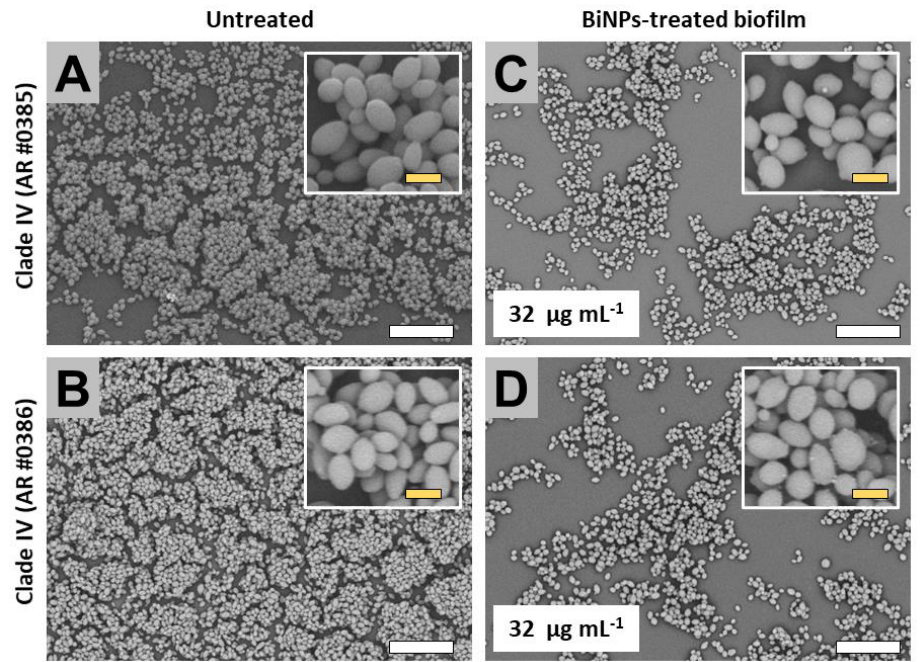
Figure 6. SEM observations on the BiNP antibiofilm activity on the C. auris strains from the Clade IV. When compared to the untreated control, BiNP-treated samples exhibited a reduction in the biofilm formation on both strains no. 0385 ( A, C ), and no. 0386 ( B, D ). No effect on cell morphology was observed on BiNP-treated samples ( B, D ). Scale bar: yellow 2 µm, white = 20 µm.